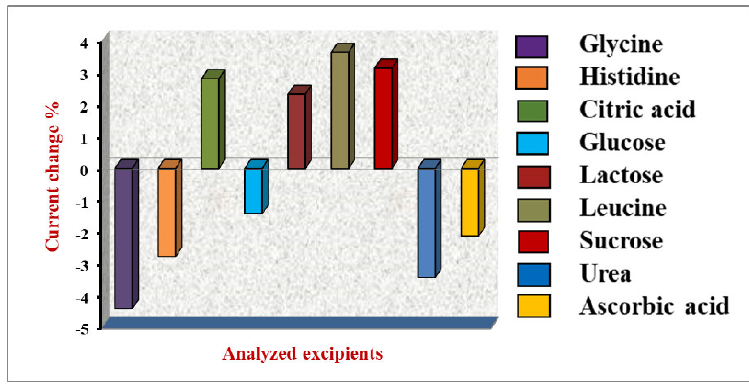
Figure 7. Effect of excipients on the peak current of CIP.